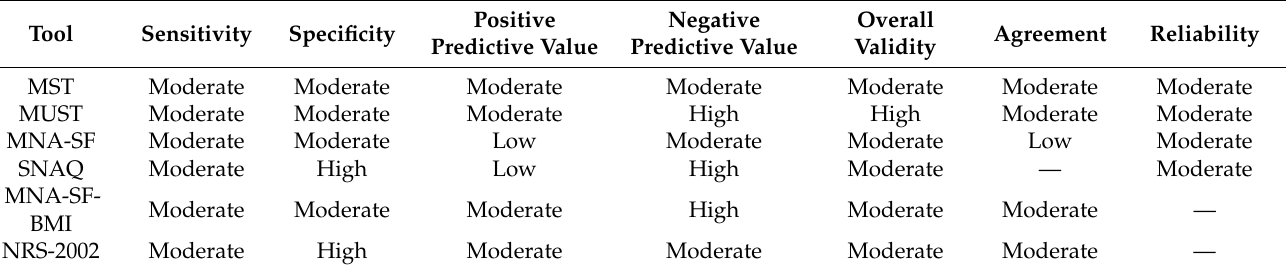
Table 9. Validity of different screening